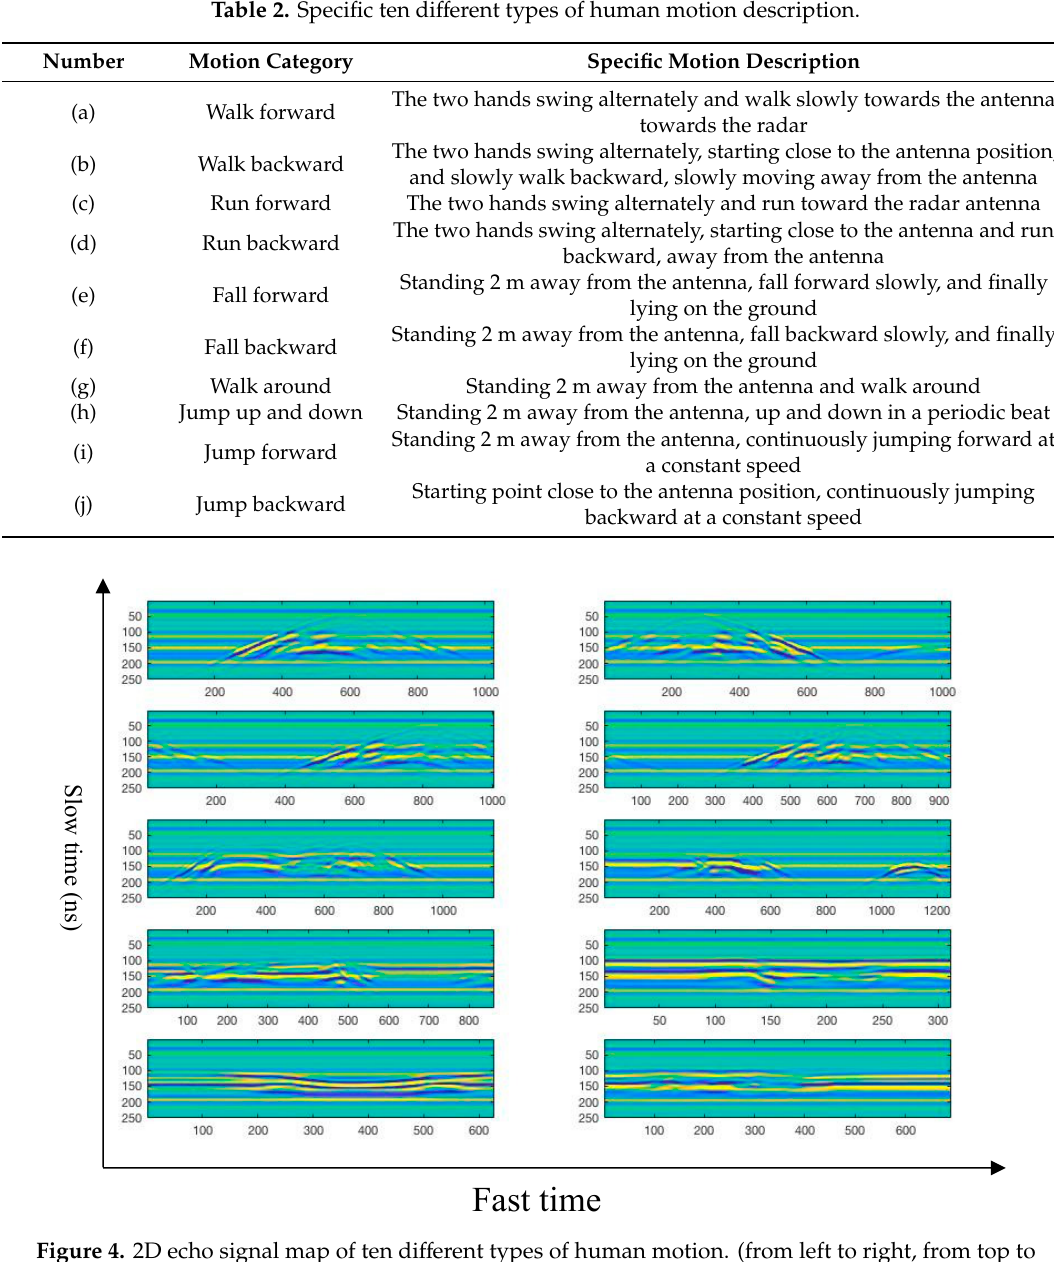
Figure 4. 2D echo signal map of ten different types of human motion. (from left to right, from top to bottom, motion a ~ motion j 2D echo signal).